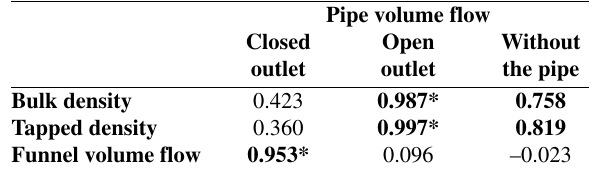
Table 7. Correlation matrix between volume flow rate for all outlet conditions and bulk powder properties (bulk and tapped densities,